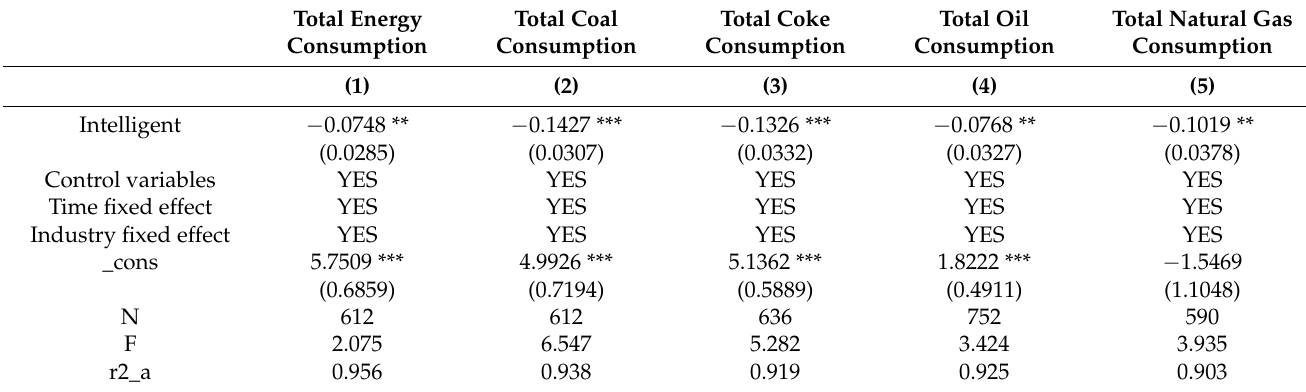
Table 12. The impact of intelligent manufacturing on energy